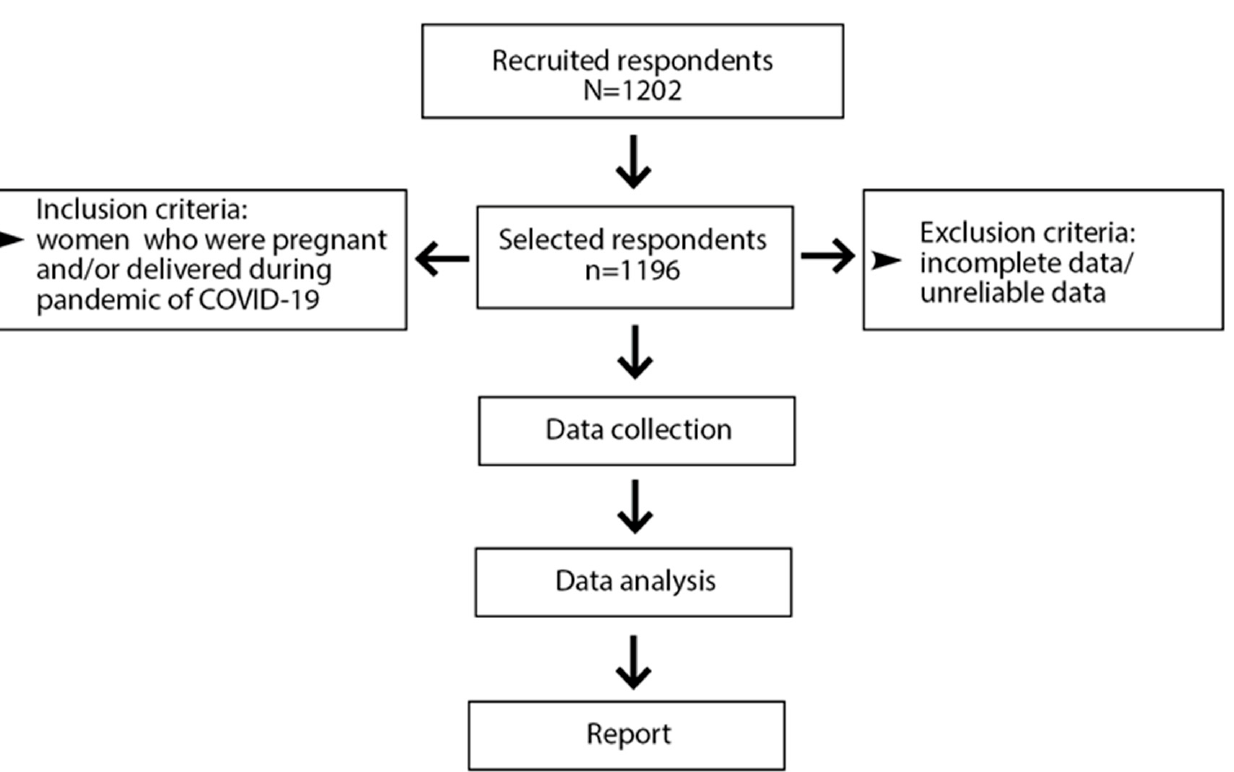
Figure 1. Flow chart of respondents included in the study.